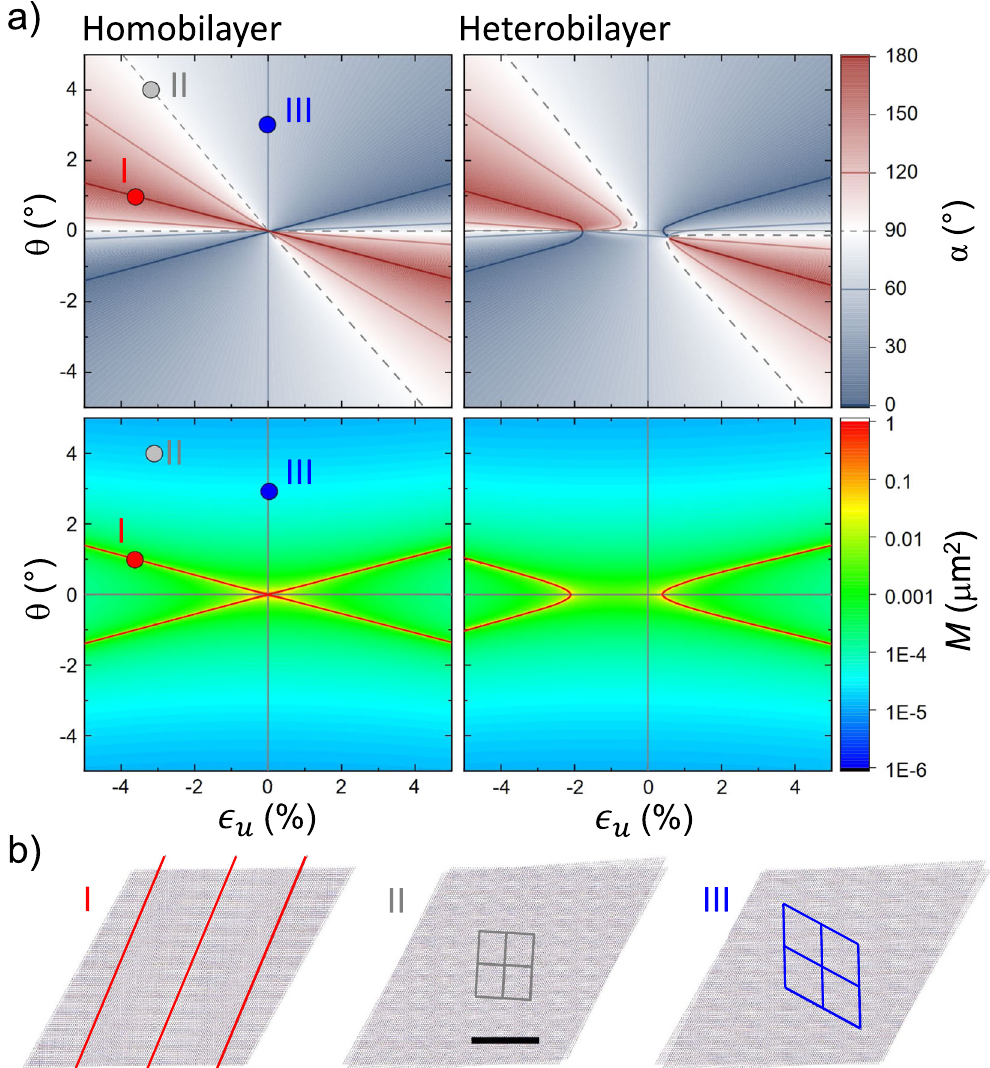
Fig. 4 Effects of uniaxial heterostrain on the geometry and size of moiré lattices formed from hexagonal bilayers. a Relative angle α (upper panels) and moiré lattice area M (lower panels) as function of ϵ u and θ for the homobilayer (left panels) and heterobilayer structure (right panels). Gray dotted lines denote con fi gurations in which the moiré lattice is rectangular ( α = 90°). The spots labeled as I, II, and III correspond to the moiré lattices presented in panel b . b Illustration of moiré lattices corresponding to the points labeled as I, II, and III in panel a and in Fig. 3b. The scale bar in II has a length of 30 nm and is valid for all real space moiré patterns I – III. Case I shows a 1D moiré lattice, II a rectangular one, and III a hexagonal